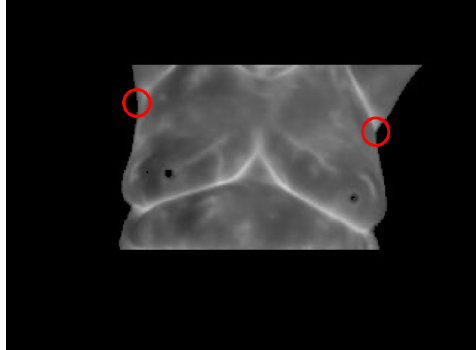
Figure 11. Armpit points with the highest slope